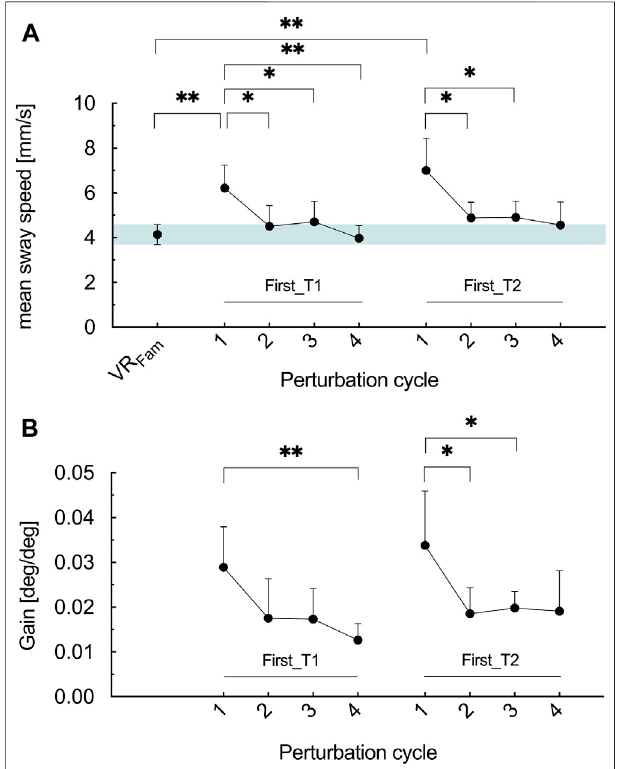
FIGURE 4 | (A) Mean COM sway speed for the reference condition